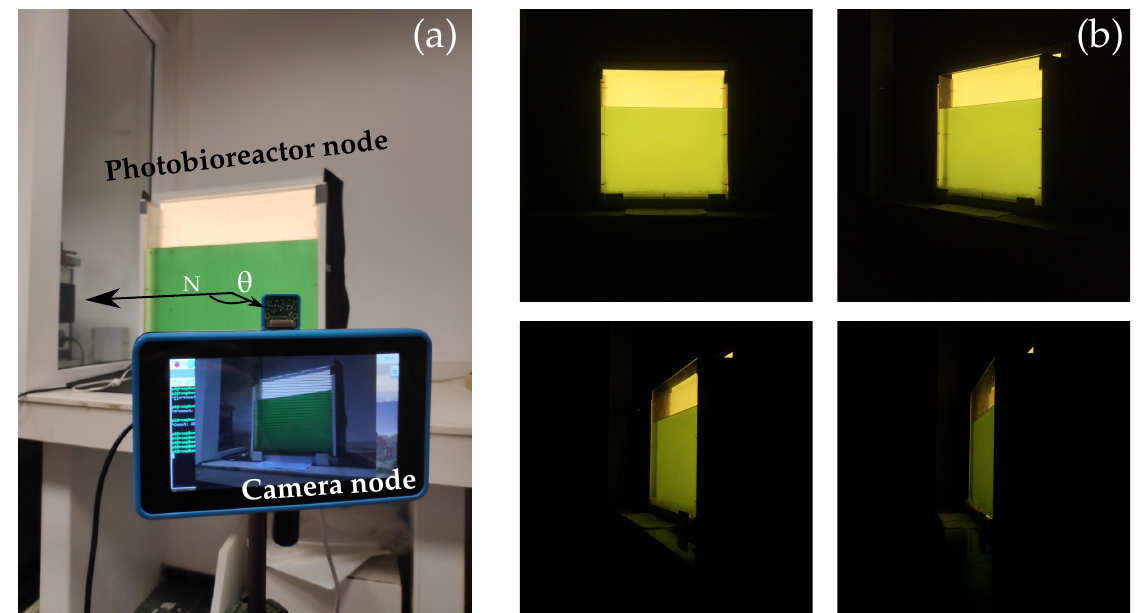
Figure 6. Pictures of the indoor experiment. ( a ) shows the experimental setup, and ( b ) depicts exemplary images captured at different angles for different biomass